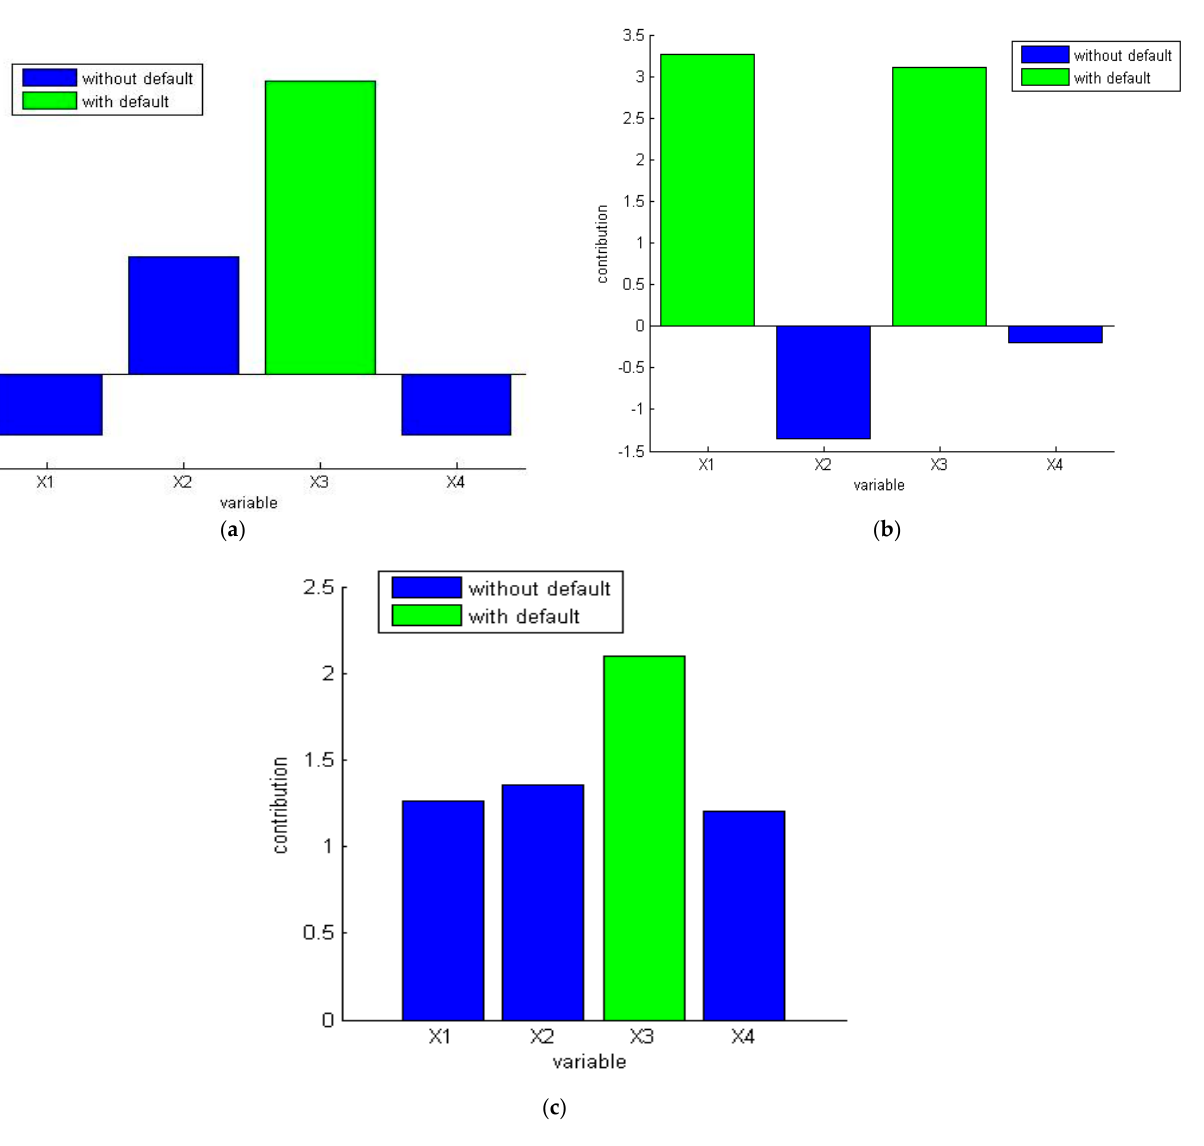
Figure 12. Fault isolation using ( a ) monoscale kernel PCA, ( b ) neural PCA, and ( c ) traditional PCA.